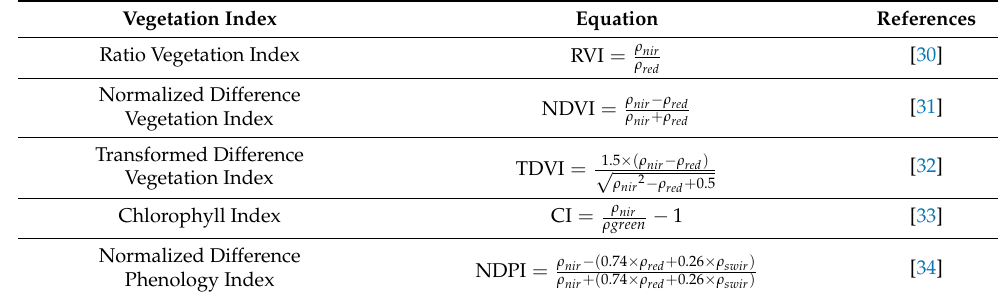
Figure 2. The distribution of the in situ LAI in Inner Mongolia grassland ( a ) and the band settings of Landsat 8 OLI and reflectance of the sample plots ( b ). Table 1. Vegetation indices used in this